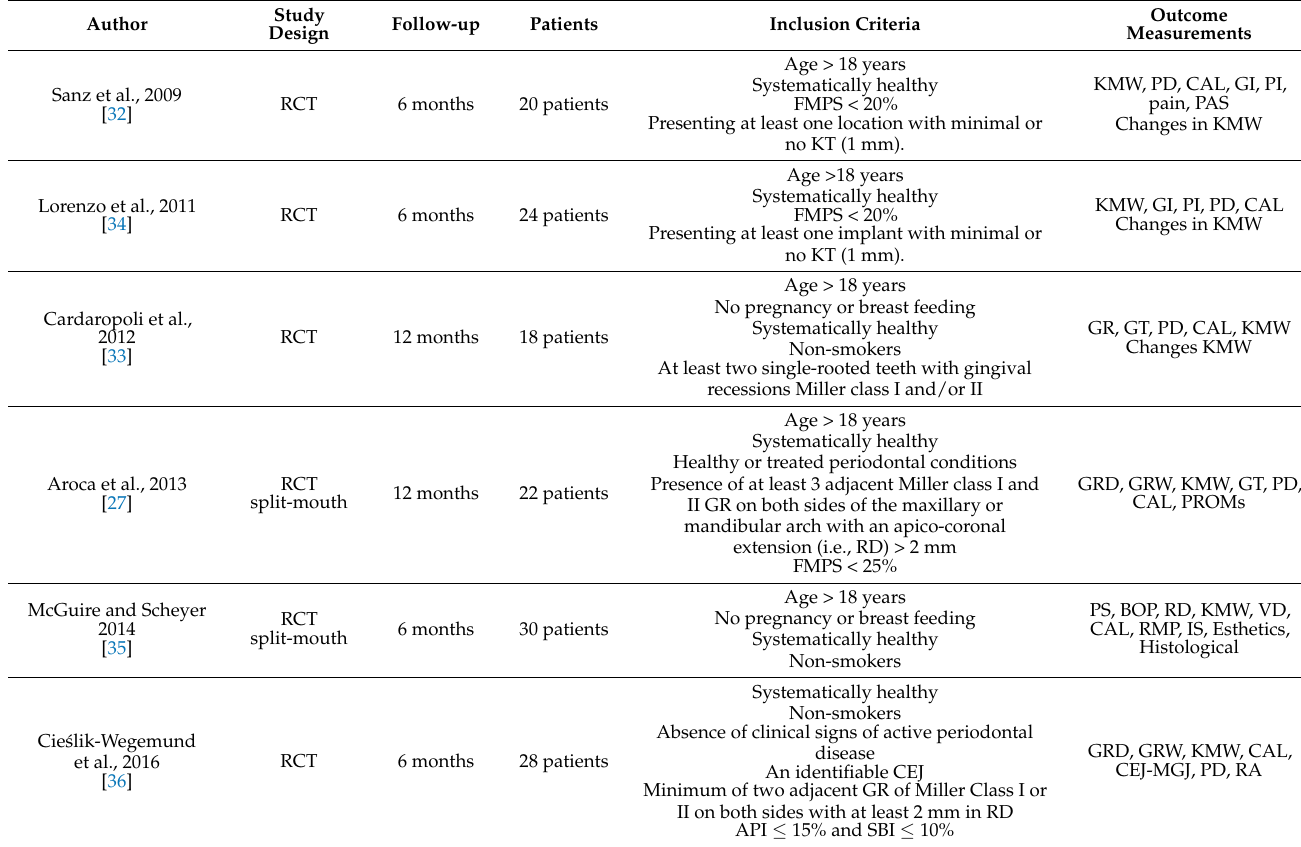
Figure 2. Different therapeutic options for soft tissue augmentation. Data are presented as a percentage of patients treated with each alternative compared to the total number of patients. Connective tissue graft (CTG), free gingival graft (FGG). Table 3. General overview of included studies’ design.